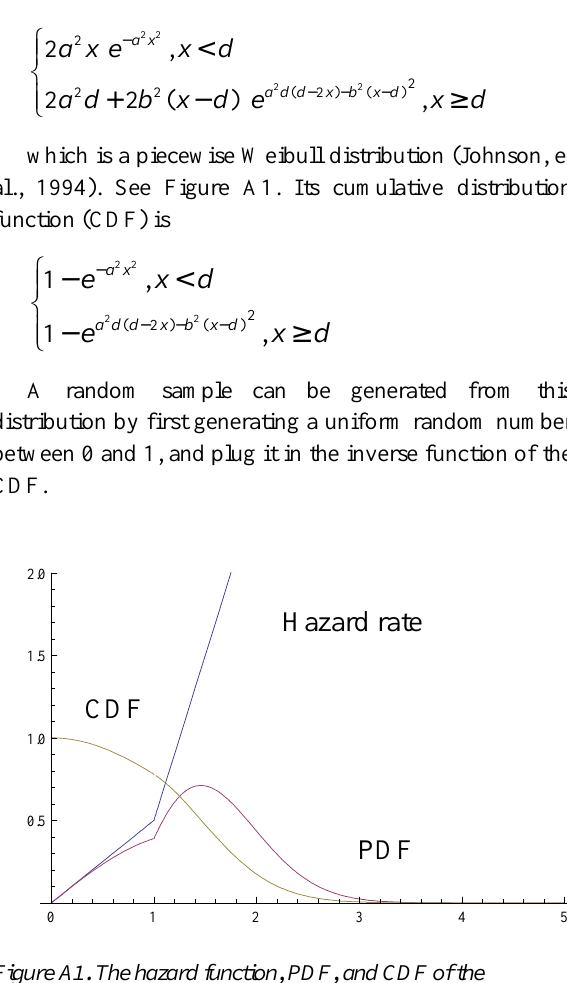
Figure A1. The hazard function, PDF, and CDF of the piecewise Weibull distribution used in Appendix A.